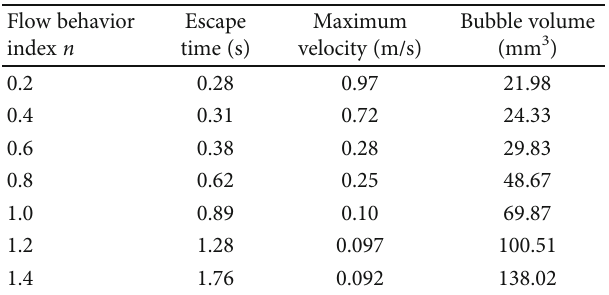
Table 5: Bubble escape time, maximum velocity, and volume for di ff erent fl ow behavior